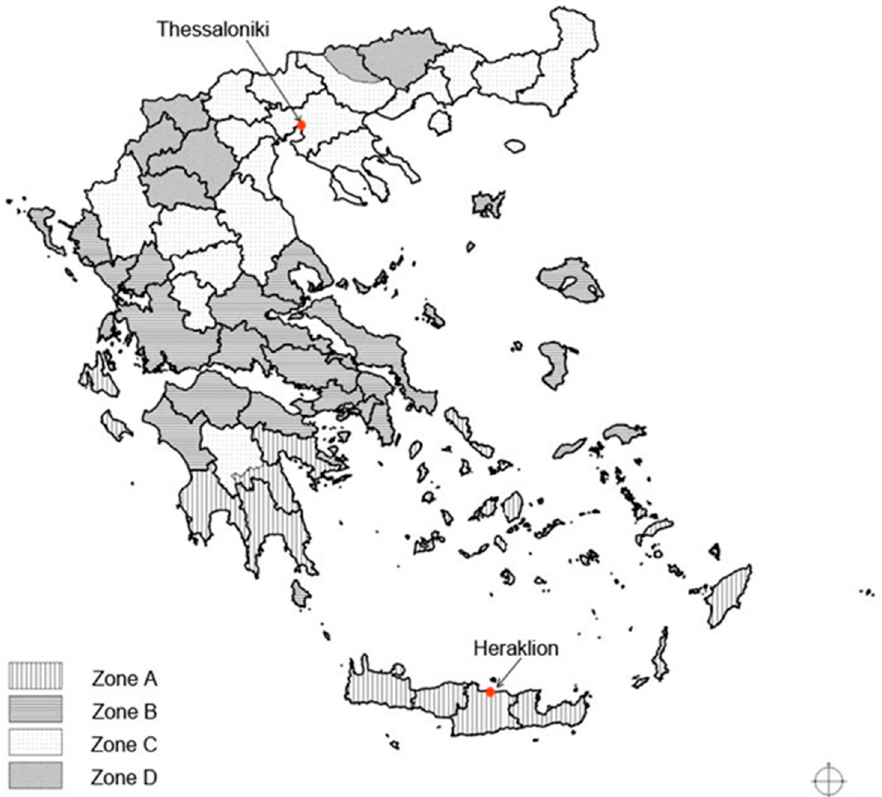
Figure 1. The four climatic zones of Greece as defined by the national energy performance regulation and the two examined cities (Thessaloniki and Heraklion) position in the map. Source: [33], edited by the authors.